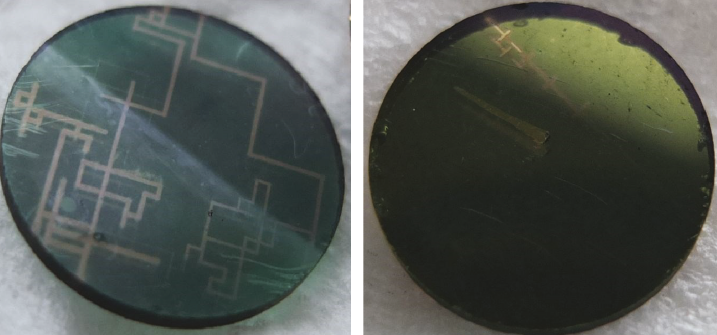
Figure 3: PANI-S on glass and gold with structures drawn with 1064 excitation laser. Line thickness varies from 40 to 100 μ m depending on the laser power (from 0.1 to 2